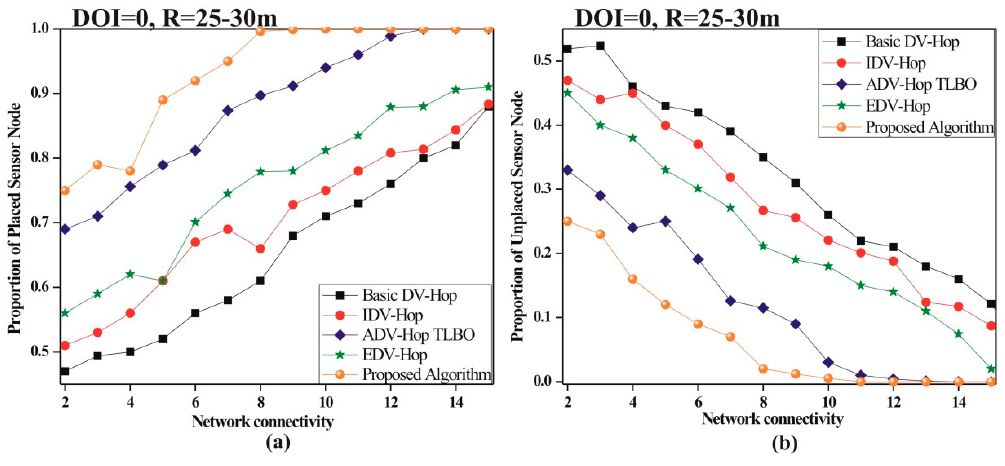
Figure 9. Impact of network connectivity on ( a ) proportion of unplaced sensor nodes (PUSN) ( b )